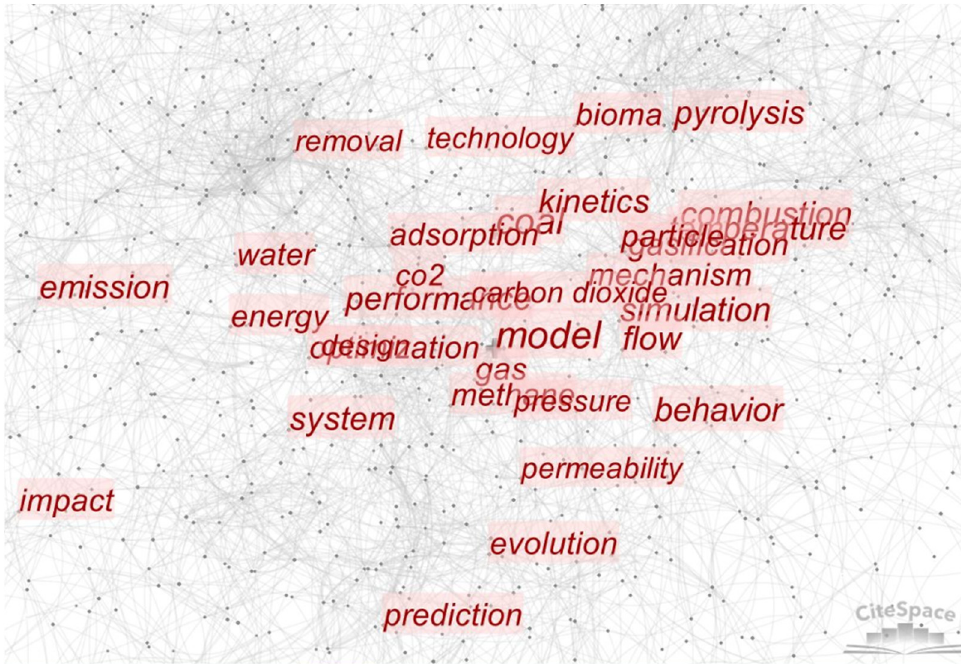
Figure 10. Visualization of editors’ key words.